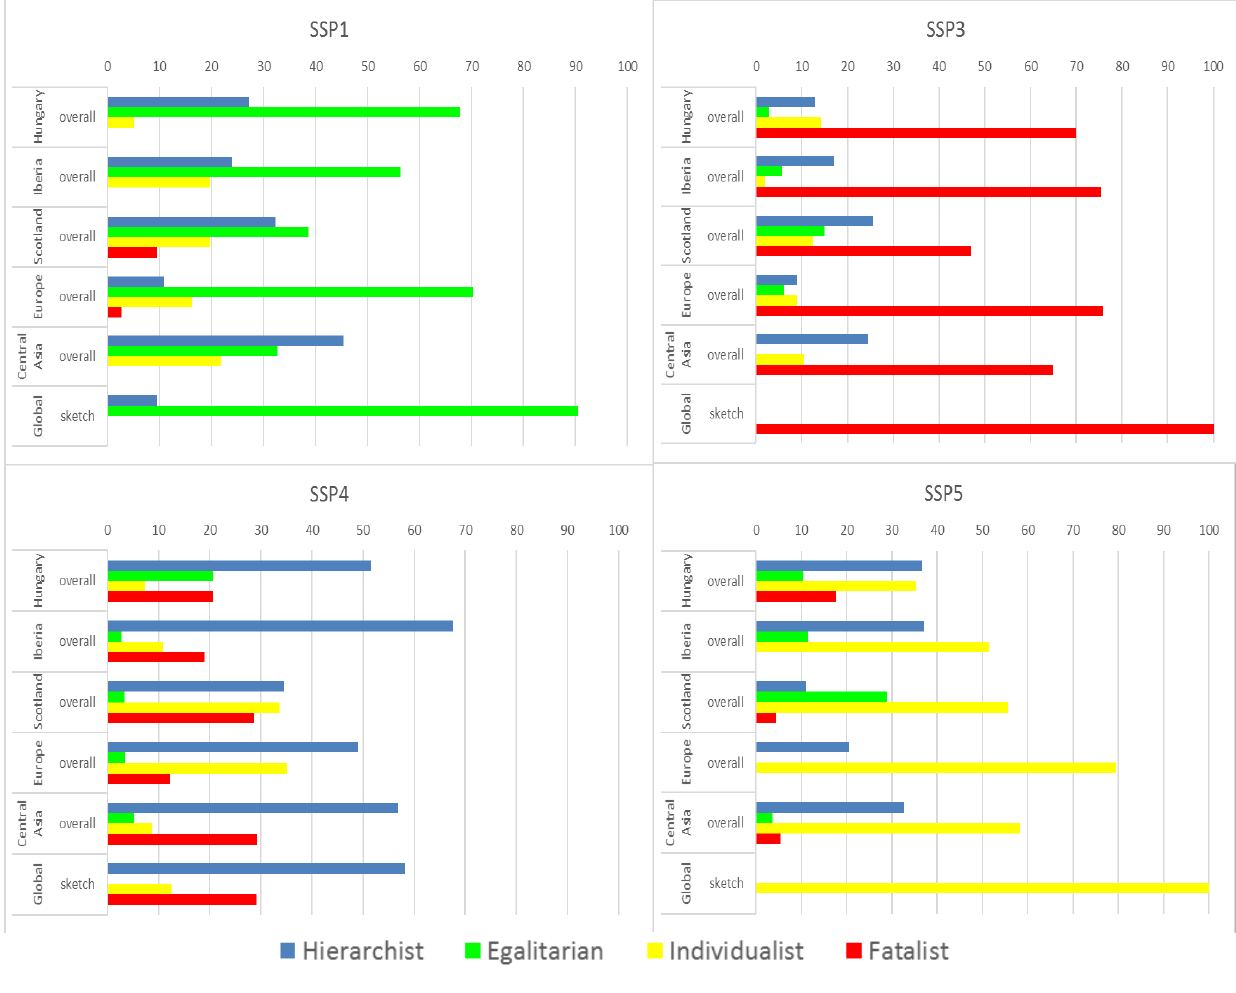
Figure A2: Analysis of worldviews (from expert